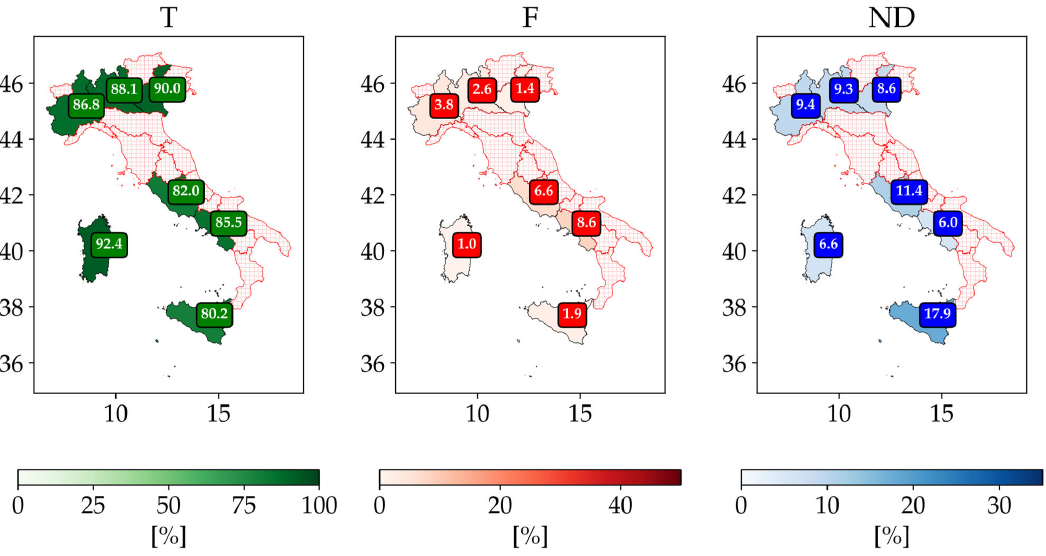
Figure 21. Regional Comparison of the 2nd Harmonic Criterion classification label rate for the CN Subset.